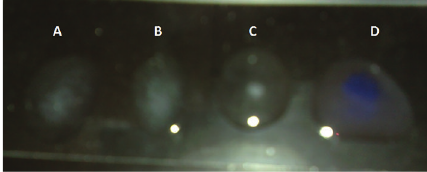
Figure 9: Agglutination experiment all samples contain antibodies plus (A) S. typhimurium ATCC 14028, (B) STGs from experiment 1, (C) STGs from experiment 2, and (D) the kit control (O antigen).